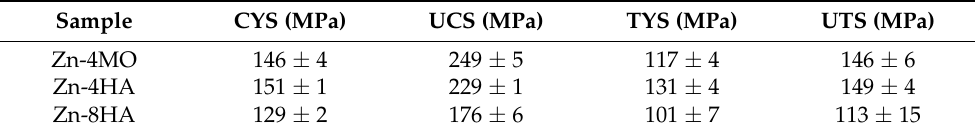
Figure 4. Engineering stress-strain curves obtained by ( a ) compressive and ( b ) tensile measurements of zinc composites. Table 5. Summary of the compressive and tensile characteristics.